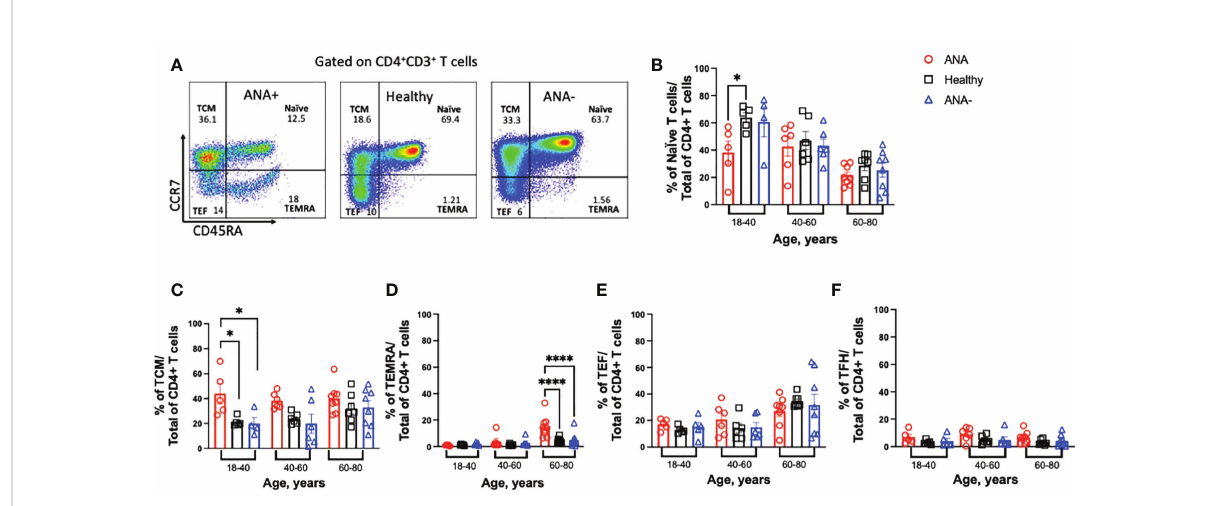
FIGURE 2 Young ANA-positive patients have reduced naïve and increased differentiated CD4+ T cells. PBMCs were isolated from whole blood and stained with antibodies to identify T cell subsets. (A) Gating strategy to visualize naïve, T central memory (TCM), terminally differentiated effector memory (TEMRA), and T effector (TEF) CD4+ T cells by fl ow cytometry. The frequencies of (B) naïve, (C) TCM, (D) TEMRA, (E) TEF, and (F) T follicular helper (TFH) T cell subsets of total CD4+ T cells was determined in ANA-positive patients, ANA-negative patients, and healthy blood donors. Each data point re fl ects one subject (ANA-positive = 20, ANA-negative = 20, healthy blood donors = 32). Data are shown as mean ± SEM and analyzed by a one-way ANOVA test followed by Sidak ’ s multiple comparison test; *p<0.05,